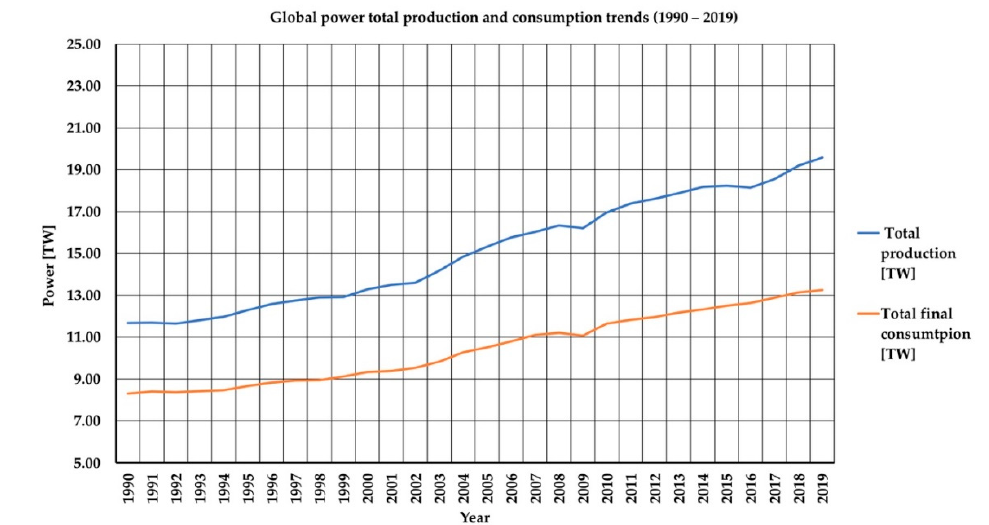
Figure 2. Total global power production and consumption, expressed in terawatts, from year 1990 to year 2019. International Energy Agency Data (data available from: [51]).